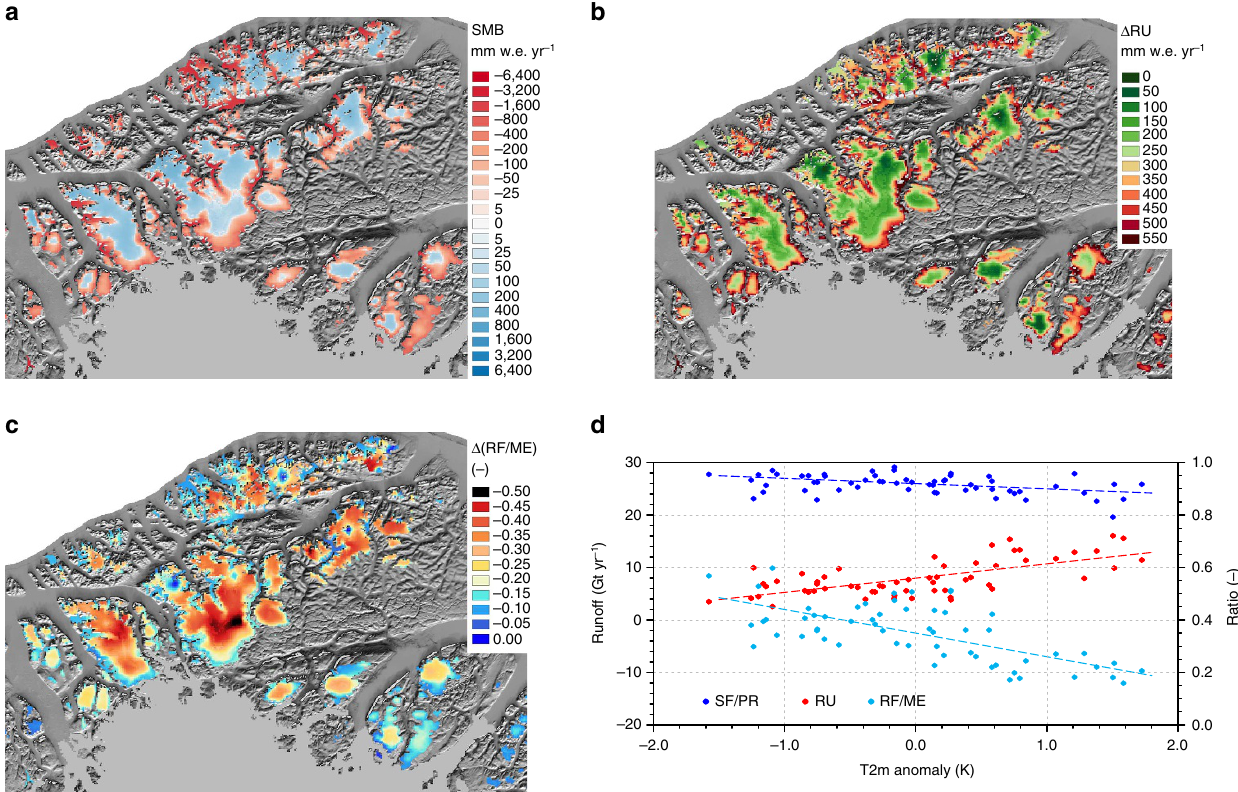
Figure 5 | Mass loss amplification in the Hans Tausen region. ( a ) Annual mean SMB patterns over the Hans Tausen region for 1958–2015 (black box 5 in Fig. 1), ( b ) difference in annual runoff between 1997–2015 and 1958–1996, ( c ) difference in the annual mean refreezing-to-melt ratio between 1997–2015 and 1958–1996 and ( d ) annual runoff (red), snowfall-to-precipitation ratio (dark blue) and refreezing-to-melt ratio (light blue) as a function of the anomaly in annual mean 2-m